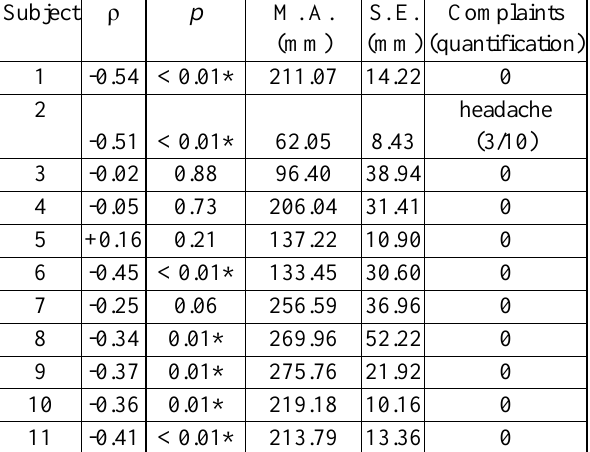
Table 1. Individual results: Spearman correlation coefficients; p values; mean amplitude of the vergence response (M. A.); standard error of the response (S. E.); complaints. A negative correlation coefficient indicates a decrease of vergence amplitude during the exposure, and conversely for a positive correlation coefficient. Statistically significant correlation coefficients are indicated by an